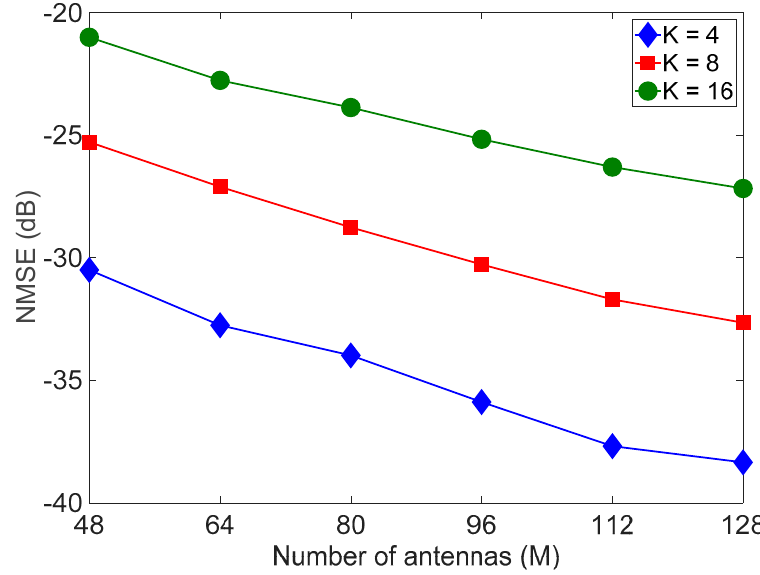
Figure 4. Normalized mean square error (NMSE) performance of MUPB according to M .